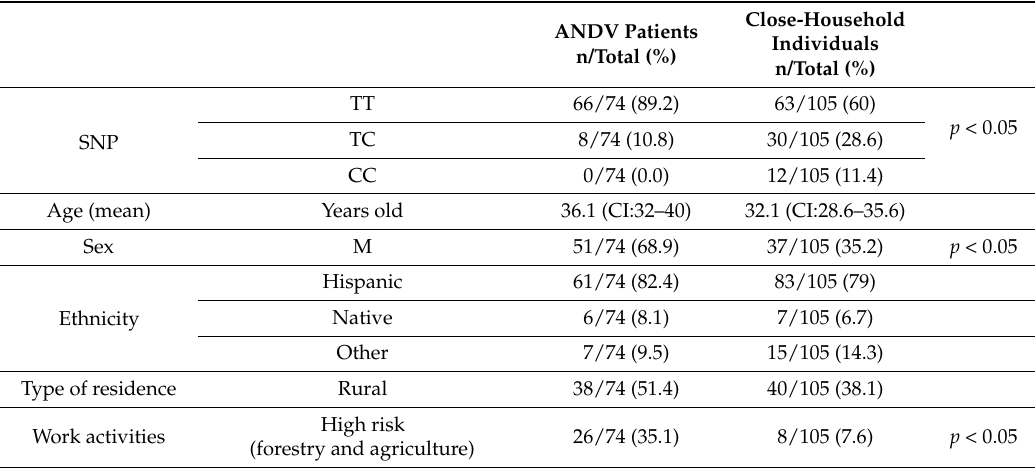
Table 1. SNP rs5918 genotypes and risk variable distribution among ANDV-infected patients and uninfected close-household